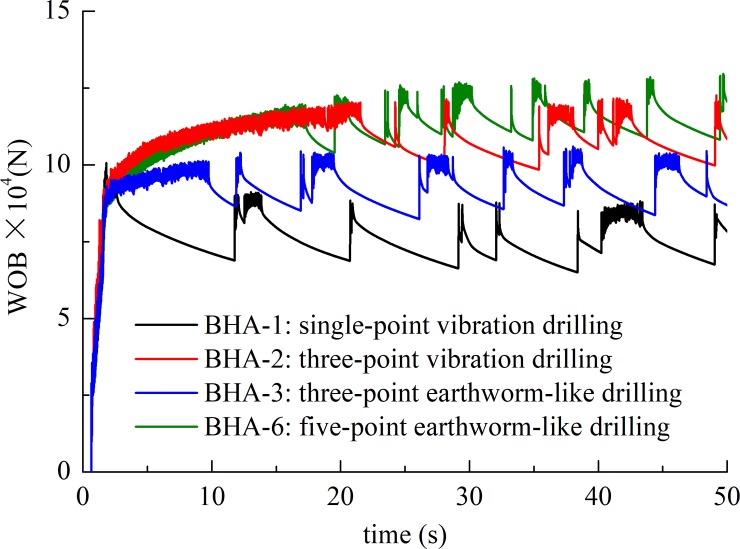
Weight on bit for the various vibration manners.https://dx.doi.org/10.17504/protocols.io.ke5ctg6.